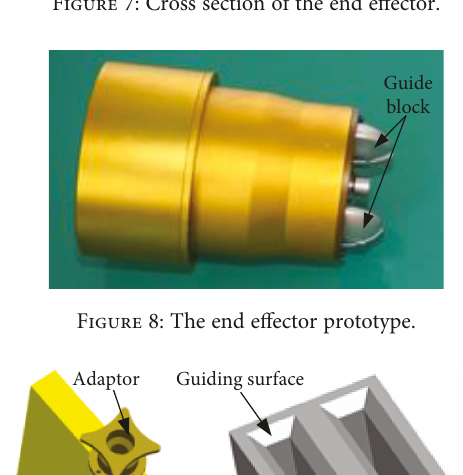
Figure 7: Cross section of the end e ff ector.